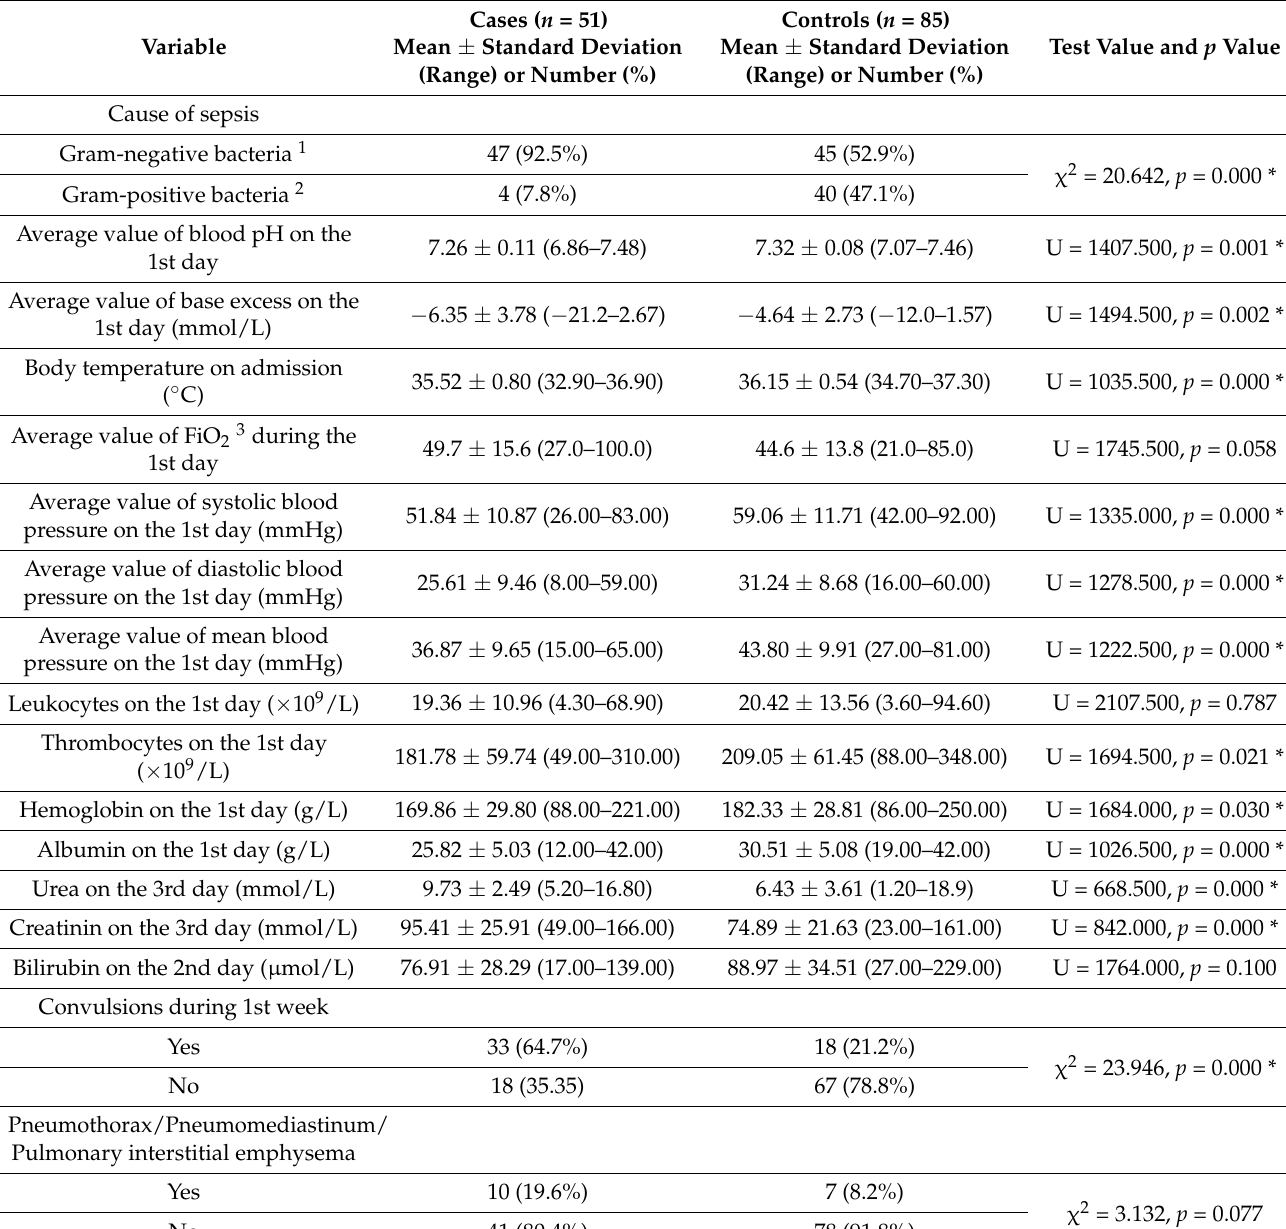
Table 3. The biochemical and clinical characteristics of the newborns.